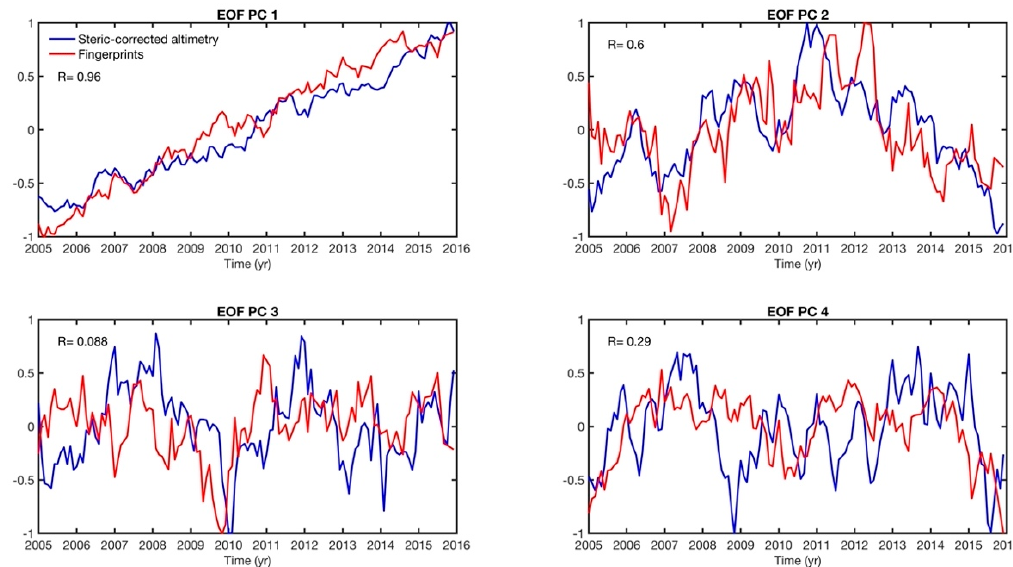
Figure 13. Principal components (PC) 1, 2, 3 and 4 of the EOF decomposition of steric-corrected altimetry-based sea-level (in blue) and absolute sea-level fingerprints (in red) for January 2005–December 2015. The R number represents the Pearson correlation between both variables in the corresponding principal component.